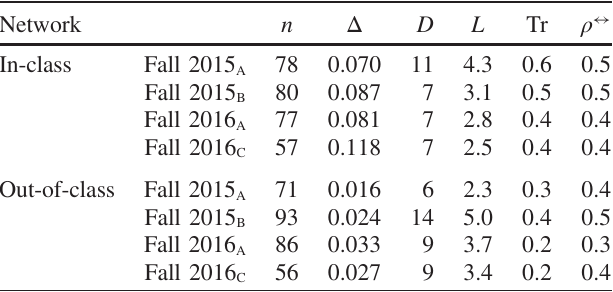
work descriptors for the in- and out-of-class networks from the third collection (week 8) for all sections: network size ( n ), network density ( Δ ), diameter (the length of the longest path between two nodes; D ), average path length (the shortest path between two nodes, averaged over all pairs of nodes; L ), transitivity (a fraction of nodes that share a neighbor “ a friend of a friend is also my friend ” ; Tr), reciprocity (a fraction of reciprocal connections; ρ ↔ ).